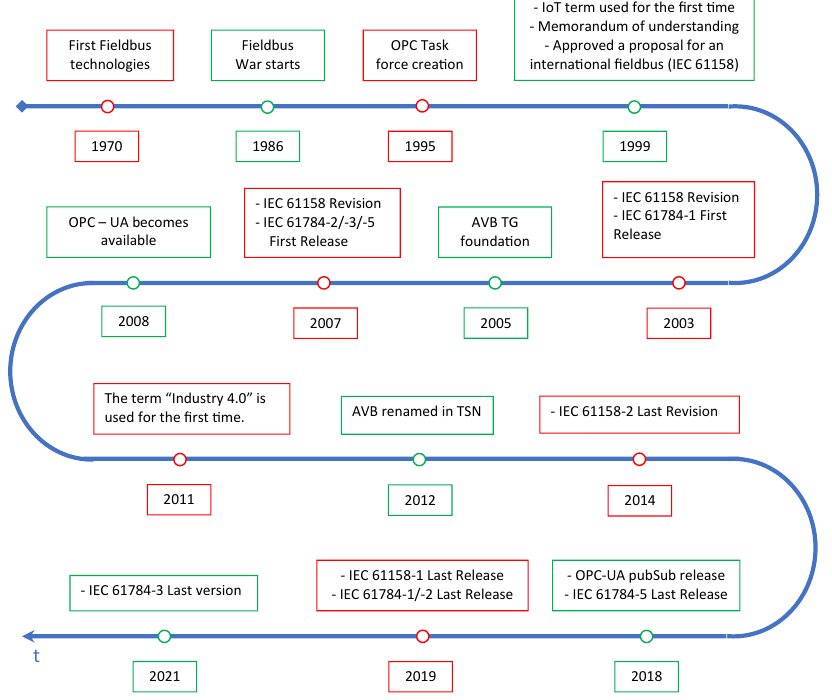
Figure 3. Main players involved in the fieldbus